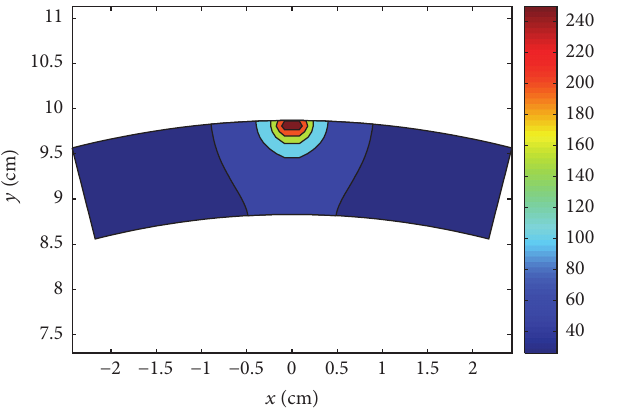
Figure 10: Temperature distribution at 𝑡 𝑓 = 30 s (dense).